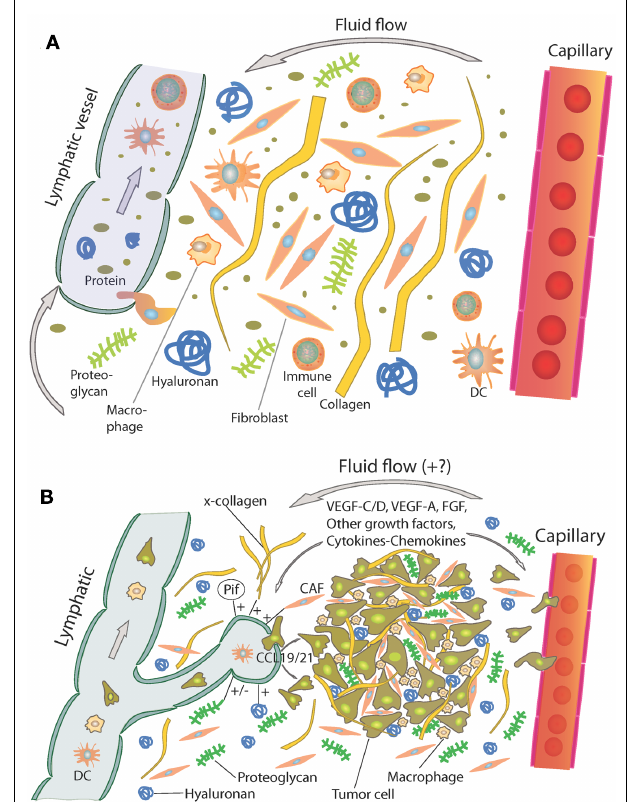
FIGURE 1 | (A) Schematic overview of the interstitium with some of its major extracellular matrix components. Fluid containing plasma proteins and other solutes is filtered from the capillary percolates through the interstitium and is absorbed and thus returned to the circulation by lymph. In addition to proteins and solutes, immune cells migrate into lymphatic vessels and are transported to lymph nodes where they may initiate an immune response. Reproduced from Wiig et al. (128) with permission. (B) Role of the extracellular matrix and microenvironment in lymphangiogenesis in tumors. Growth factors and cytokines produced by tumor cells and stroma are transported by fluid flow and down a diffusion gradient to lymphatics and blood capillaries. Tumor and immune cells (expressing CCR7) are chemoattracted to and enter peritumoral initial lymphatics expressing CCL19/21. + (plus) and (cid:0) (minus) denote stimulating and inhibiting lymphangiogenesis, respectively. x-collagen, crosslinked collagen; Pif, interstitial fluid pressure; CAF, cancer-associated fibroblast. Reproduced from Wiig et al. (128) with